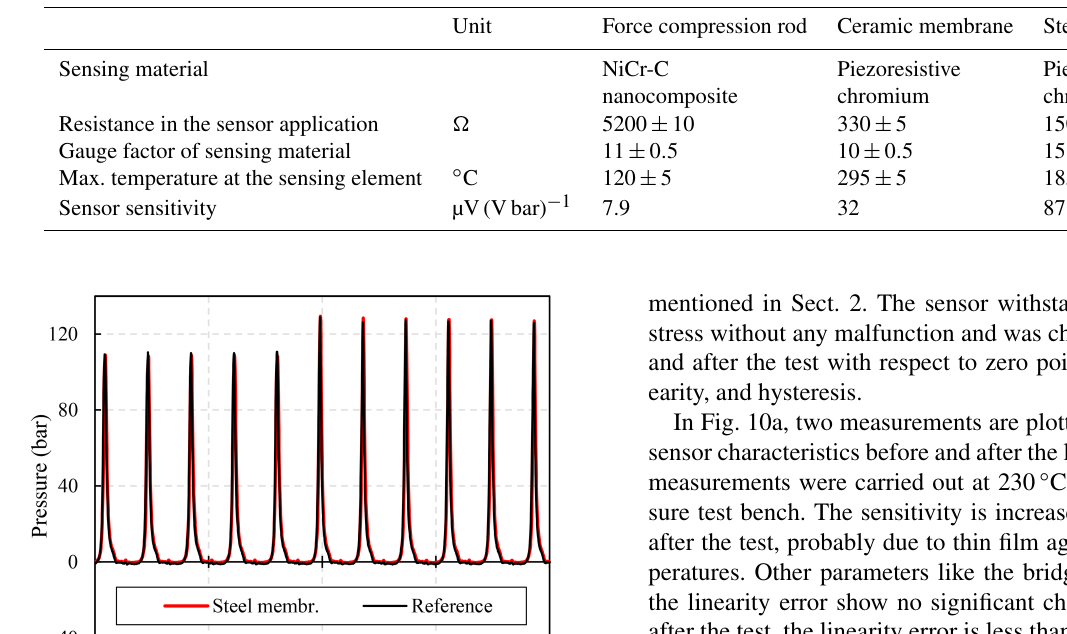
Table 3. Sensor characteristics of the different concepts.